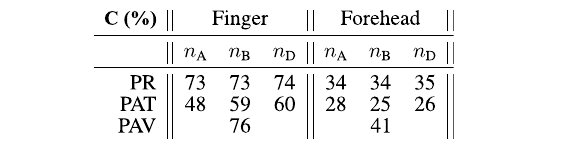
TABLE 4 Coverage results for the acute mental stress test dataset. Values of coverage are presented in %, relative to the number of heartbeats (ECG as ground